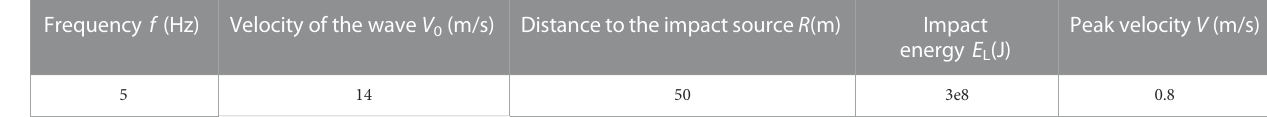
TABLE 4 The parameters of dynamic